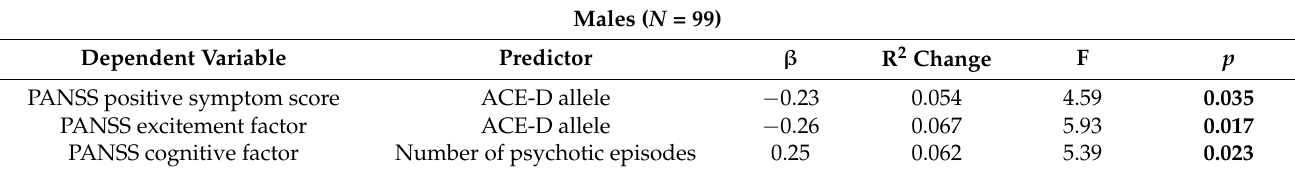
Table 4. PANSS psychopathology data after antipsychotic treatment, predicted by ACE-I/D